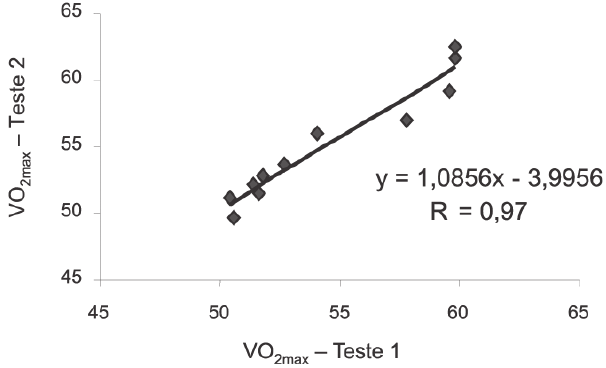
Figure 1 – Correlation of VO between the two tests (T1 vs. T2) among 2max soccer players, with 15-day interval between the